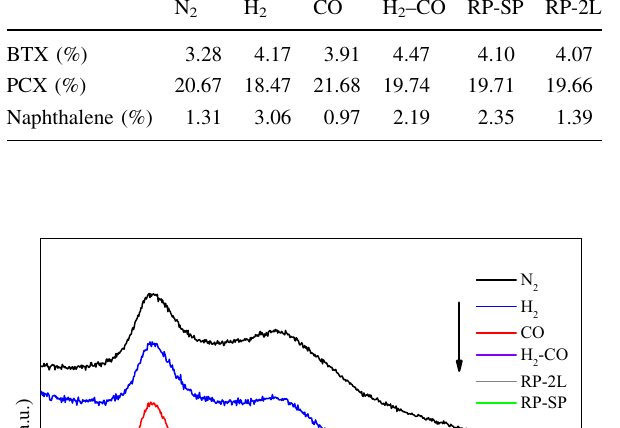
Table 3 Percentages of BTX, PCX and Naphthalene in coal tar collected under different atmospheres Type